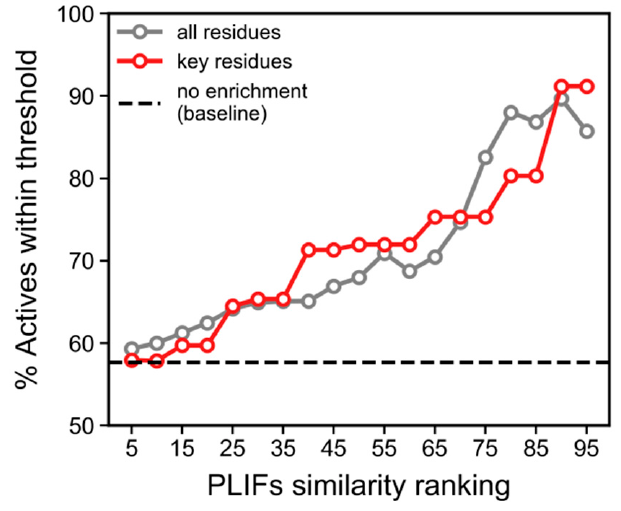
Figure 8. Enrichment curves for ChEMBL compounds, produced using PLIF similarities calculated from docking contacts with RIPK1 (5HX6, 50 poses). PLIF similarities were calculated with all residue contacts (N = 81 residues) portrayed by the grey curve, versus the six key residues that indicated frequent interactions among all crystal structures (i.e., LEU70, VAL75, LEU78, LEU129, ASP156, ASP157), portrayed by the red curve. Larger similarity ranking values on the X-axis corresponds to higher similarity.